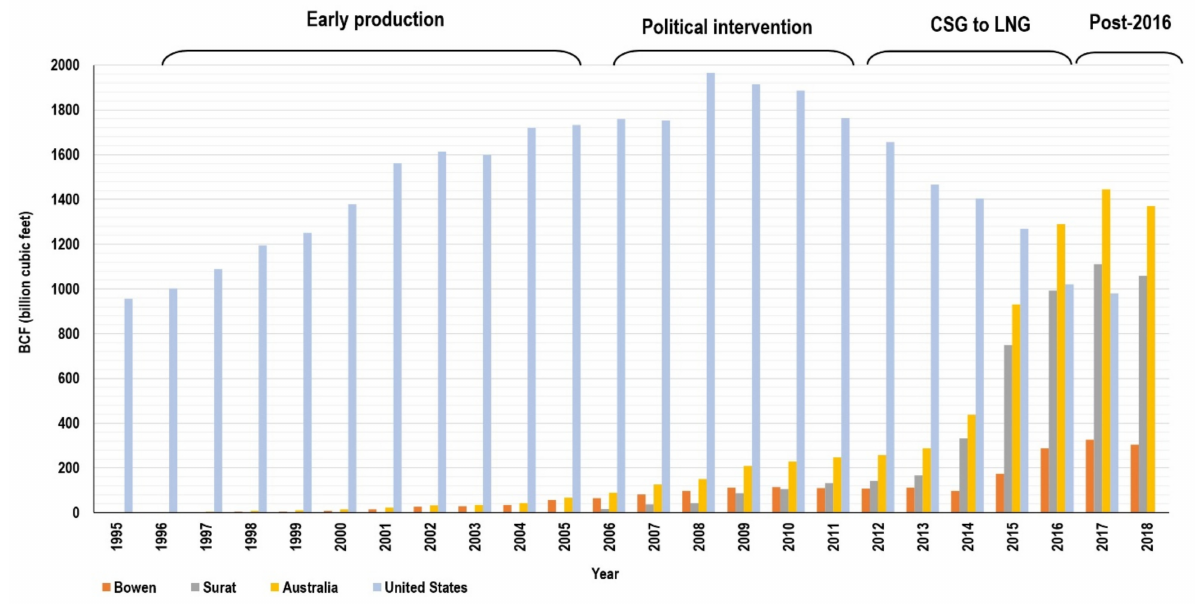
Figure 2. Annual CSG production in Australia and the US [15,16].